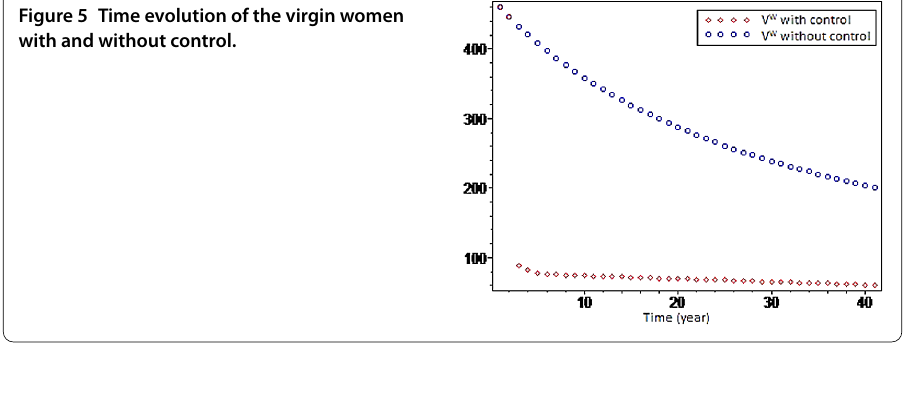
Figure 5 Time evolution of the virgin women with and without control.